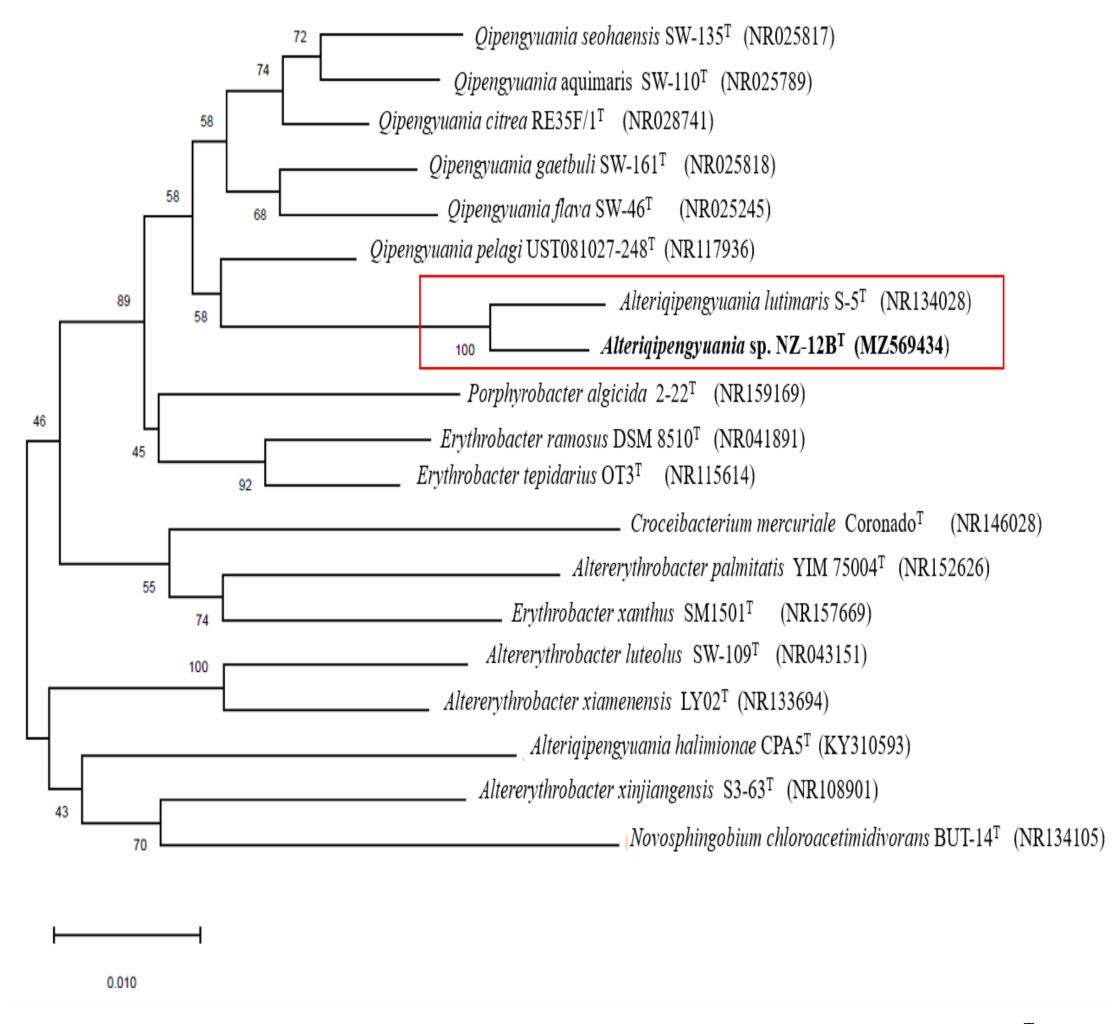
Figure 2. Neighbor joining phylogenetic tree based on almost complete 16S rRNA gene sequence of NZ-12B T and its most closely related species. The numbers above the branches are bootstrap support. Bar, 0.010 substitution per nucleotide